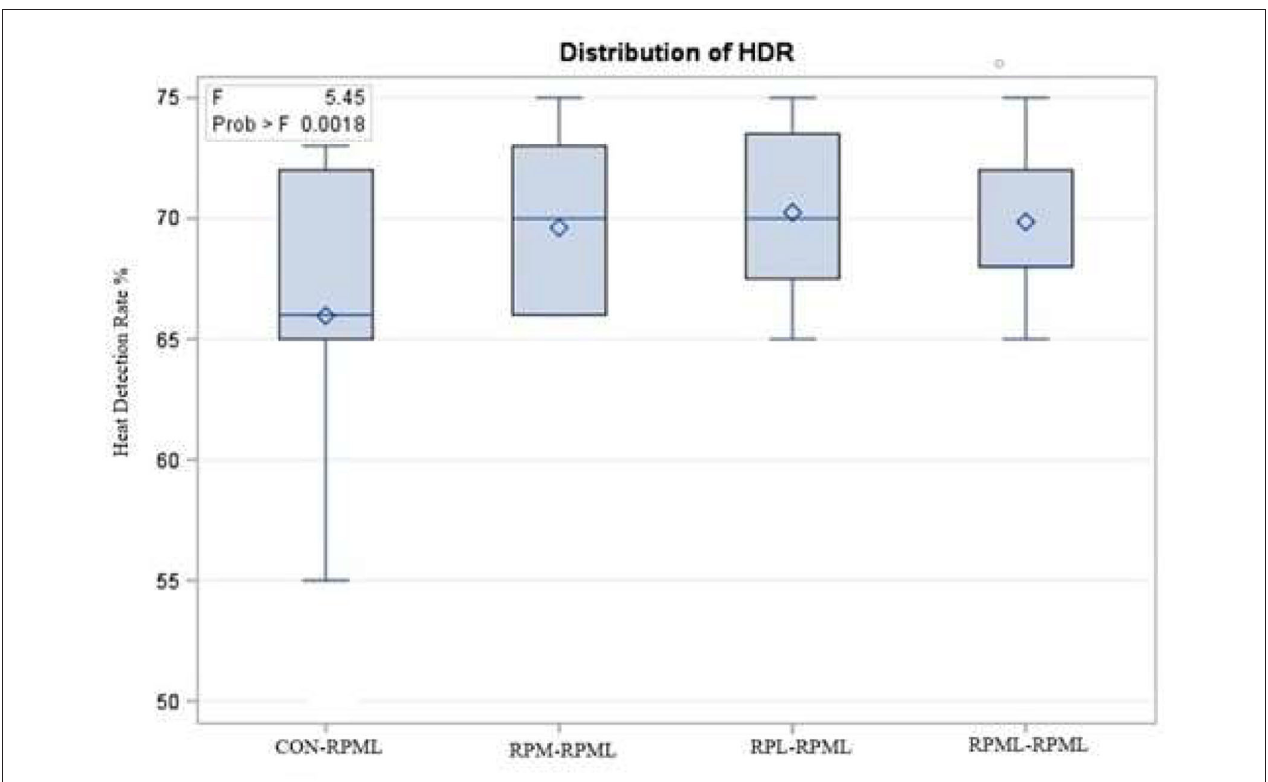
FIGURE 11 | Effect of supply ruminally protected Met and Lys to transition and milking dairy cows on heat detection rate. Values are means; standard errors are represented by vertical